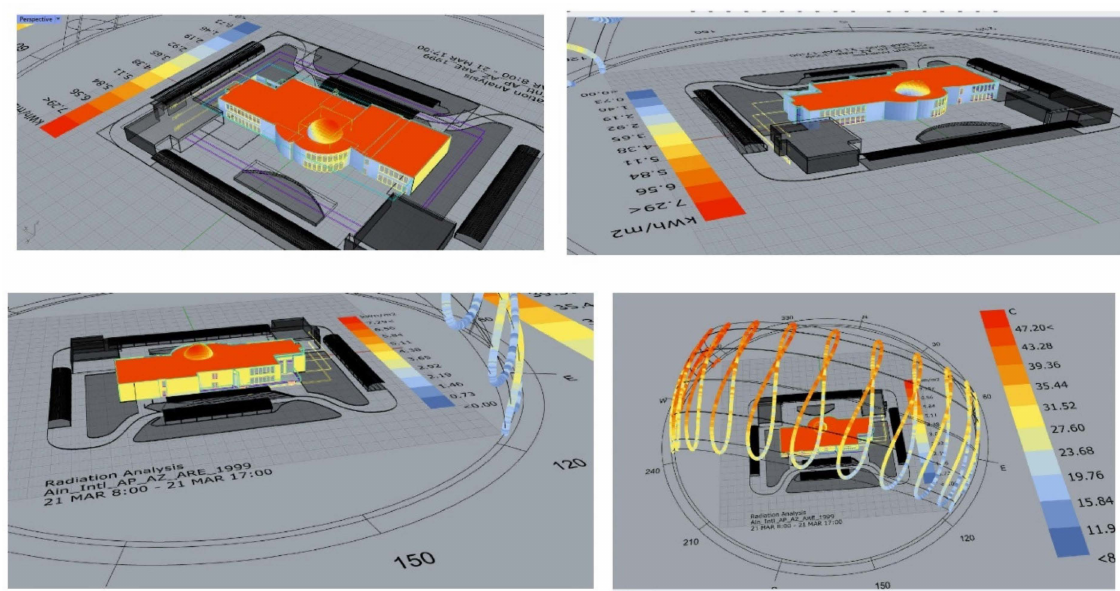
Figure 7. Grasshopper solar radiation analysis of the base